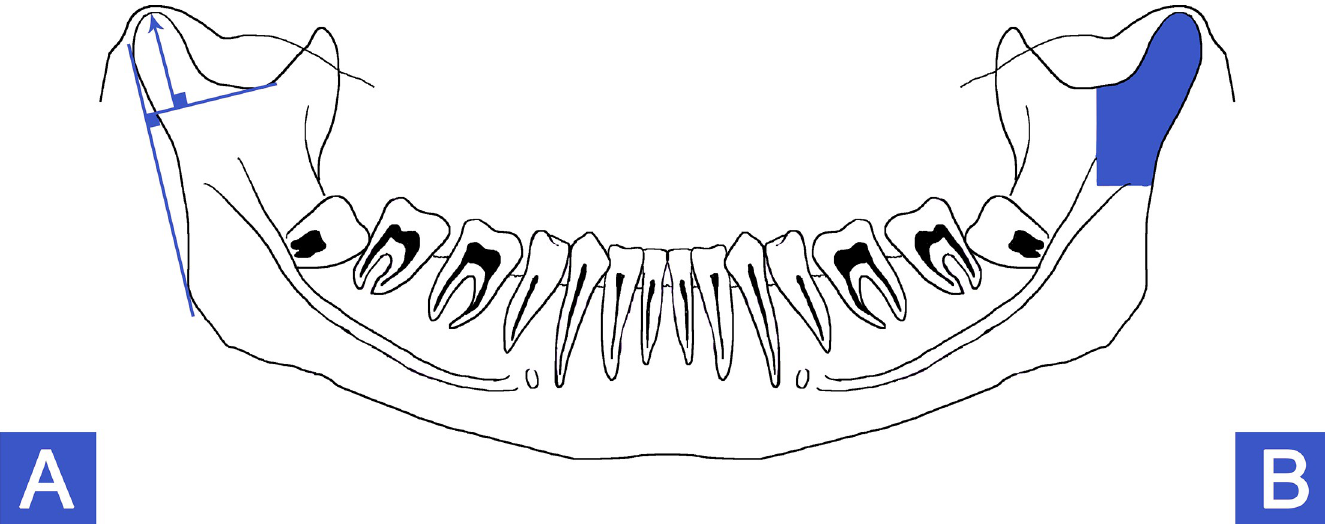
Fig 1. Panoramic landmarks related to condyle modelling measurements. A–Two lines were constructed to evaluate condylar height, one drawn tangential to the posterior edge of the mandible passing through the most posterior points of the condyle and mandibular ramus, and the perpendicular line passing through the lower end of the mandibular notch. Condylar height was measured perpendicular to the latter between the mandibular notch and the highest point of the condylar unit. B— The surface of the condylar unit was measured, contouring the lowest point of the mandibular notch to the lingula mandibulae , then perpendicular to the rear edge of the mandibular ramus. Bone modeling was determined by a differential measurement of condylar height or condylar surface defined by a percentage in relation to the larger side between right and left sides on a pre-surgical panoramic radiograph.